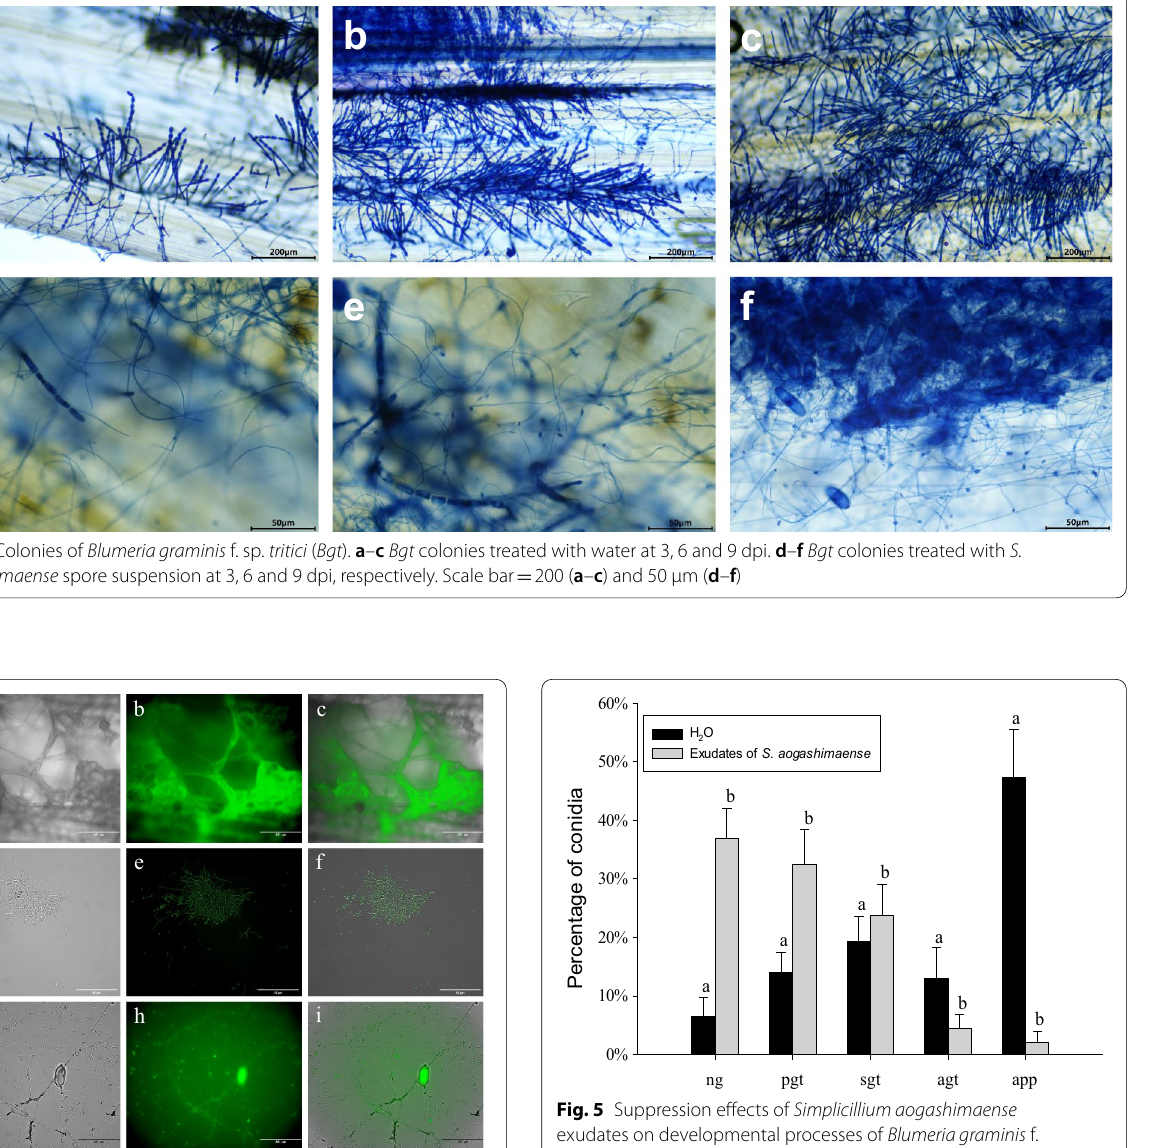
Fig. 4 Visualization of interaction between green fluorescent protein (GFP)‑transformed Simplicillium aogashimaense and Blumeria graminis f. sp. tritici ( Bgt ). a – c Mycelia of transformed S. aogashimaense on